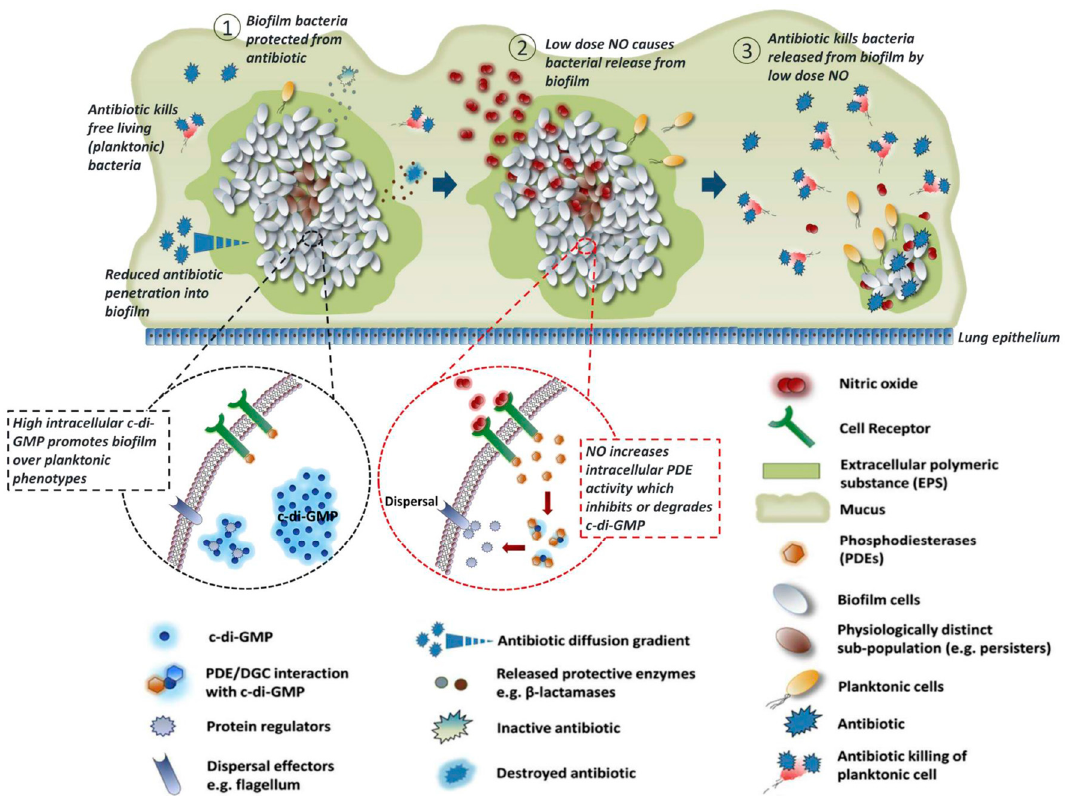
Figure 10. Disruption of biofilm antibiotic tolerance regulated by NO. ( 1 (cid:79) ) The formation of biofilms due to high concentration of c-di-GMP, which endowed bacteria antibiotic tolerance. ( 2 (cid:79) )Biofilm dispersal regulated by low dose of NO, since NO reduce the intracellular levels of c-di-GMP. ( 3 (cid:79) ) Plankronic bacteria releasing from biofilm restore sensitivity to antibiotics and are killed by antibiotics. Reproduced with permission from [151]. Copyright 2017, Elsevier.